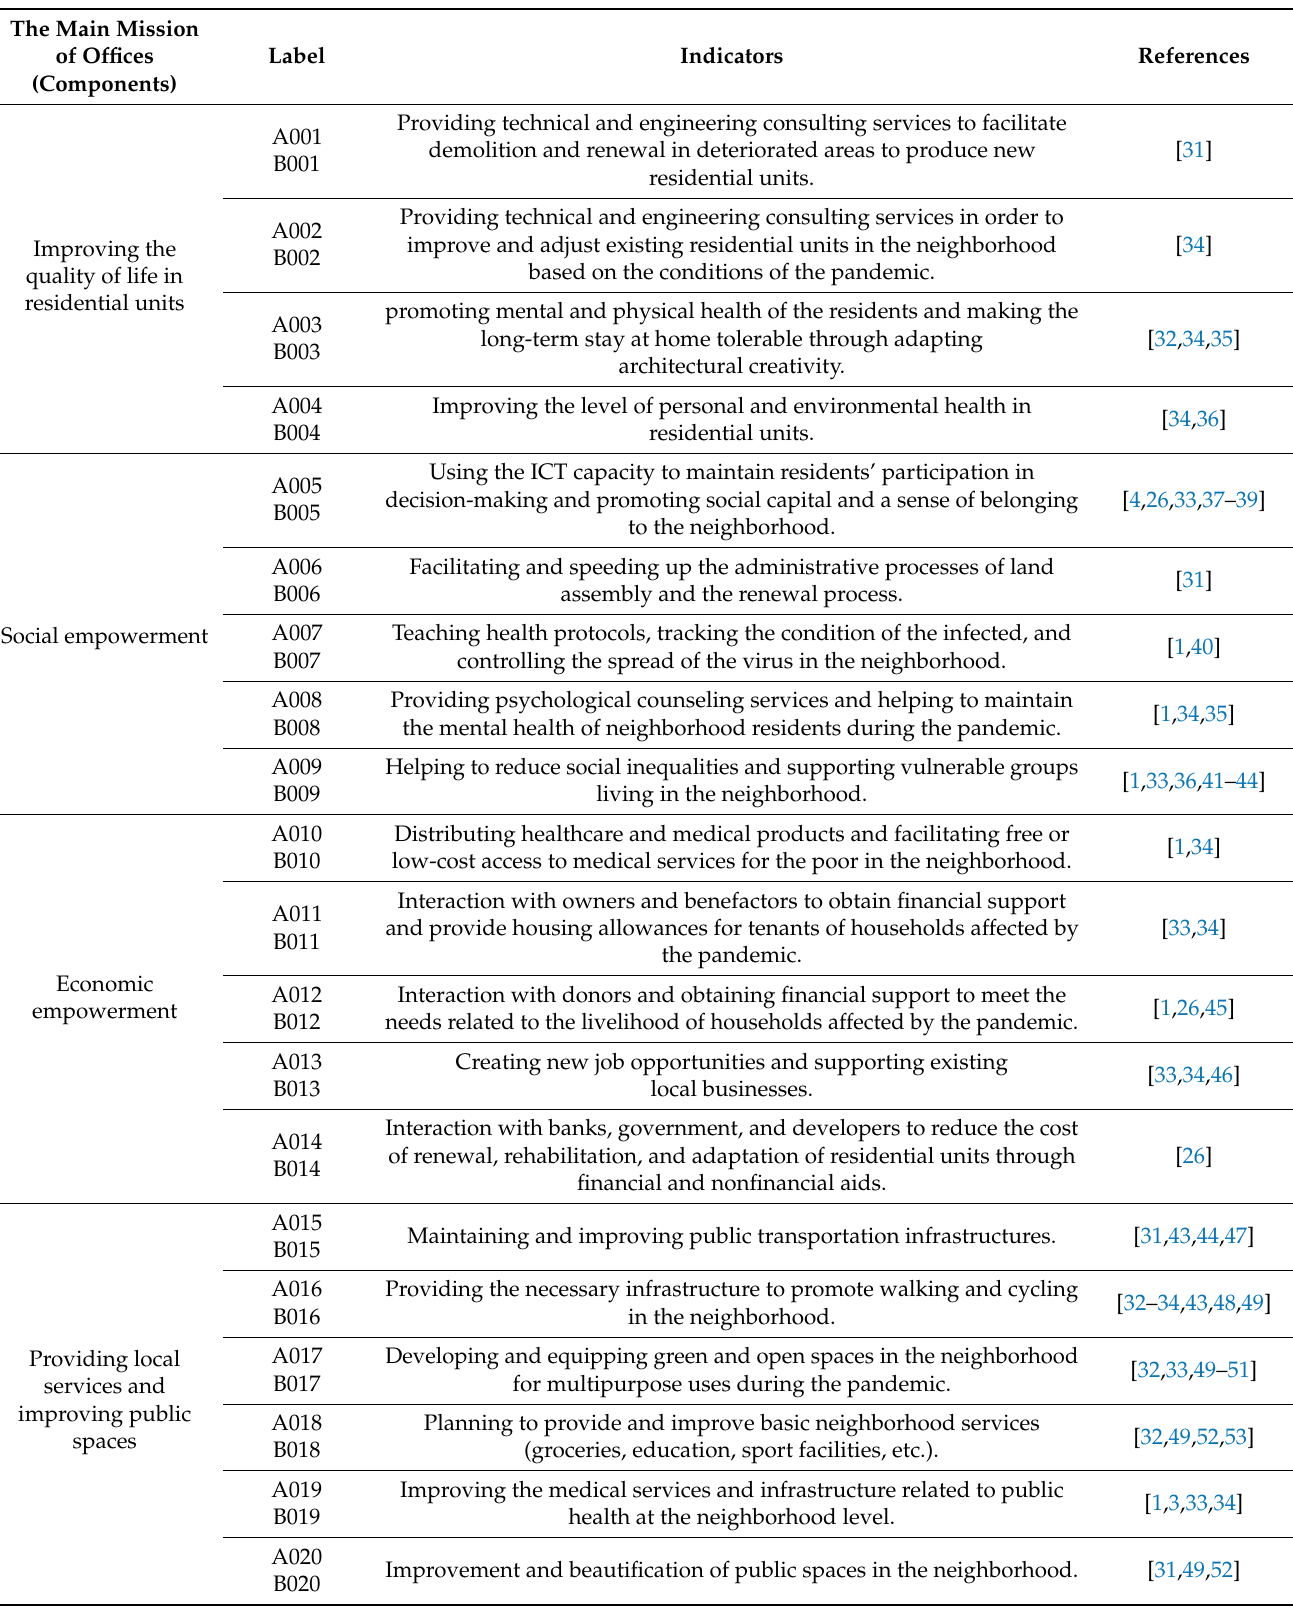
Table 1. Evaluation components and